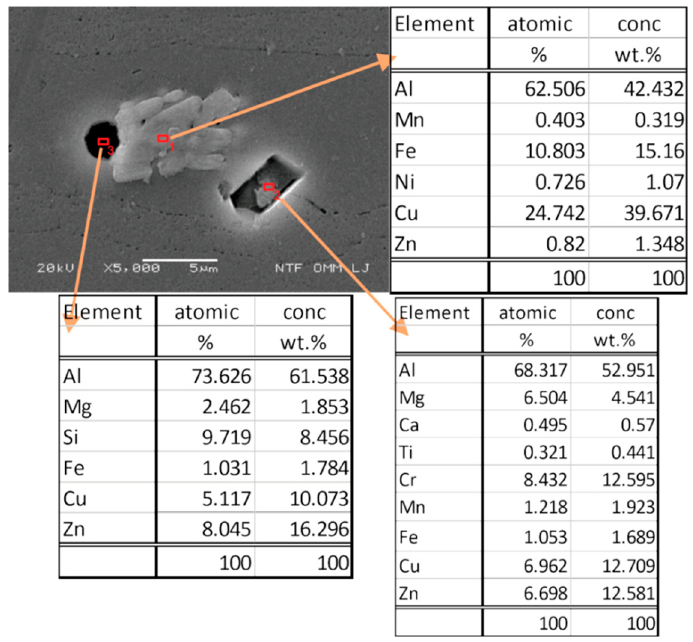
Figure 10. SEM image and chemical analysis of precipitates.